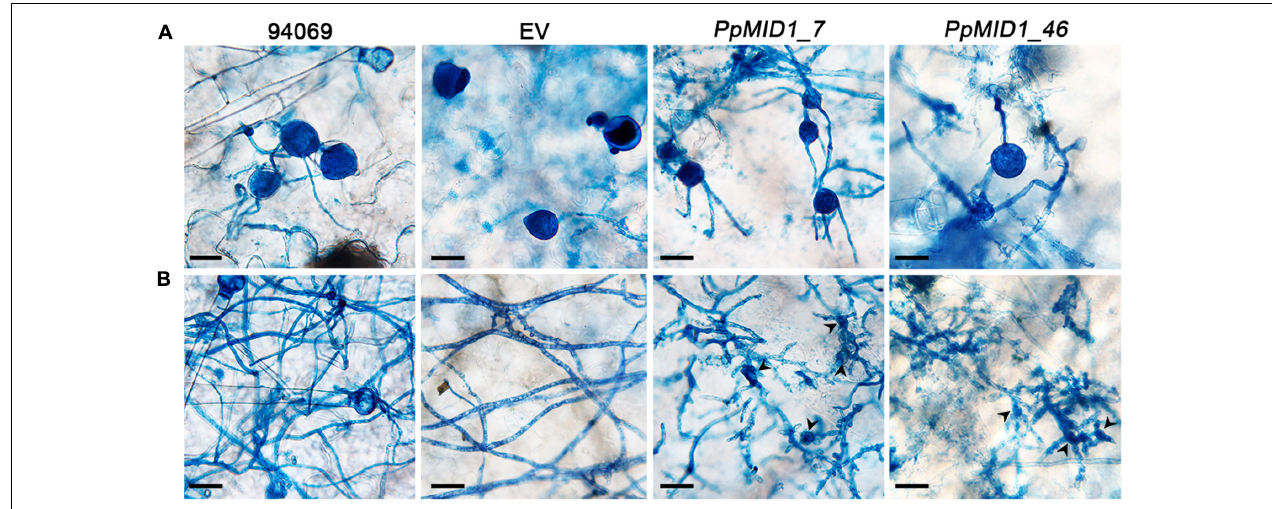
FIGURE 10 | PpMID1- silenced transformants generate highly branched mycelia and aberrant sporangia. Mycelia disks (5 mm id.) of PpMID1_7 , PpMID1_46 or wild-type Phytophthora parasitica (94069) were transferred to the center of leaves from 5-week-old Nicotiana benthamiana . After incubation in a moisture box at 25 ◦ C for 72 h, inoculated leaves were stained with trypan blue and photographed under a microscope. (A) Silenced transformants produced sporangia that germinated directly. Bar = 25 µ m. (B) Silenced transformants tended to form deformed and highly branched mycelia. Arrowheads, bulged mycelia of the silenced transformants. Bar = 25 µ